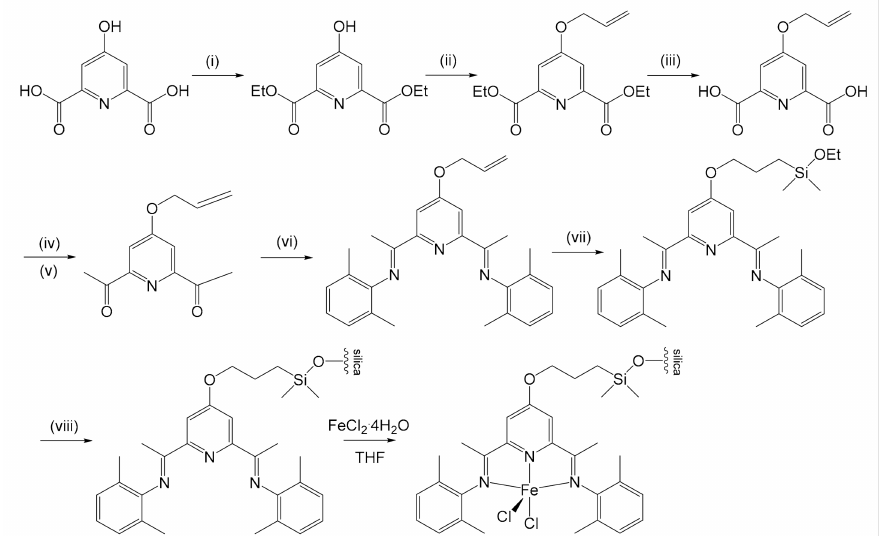
Figure 4. Kim’s immobilization strategy over silica for iron pre-catalyst [50]. Conditions: (i) EtOH, concentrated H 2 SO 4 , 90 ◦ C; (ii) K 2 CO 3 , allyl bromide, acetone, reflux; (iii) 5 eq L − 1 NaOH, THF, 50 ◦ C; (iv) SOCl 2 , DMF, 90 ◦ C; (v) CuI, MeLi, Et 2 O, THF, − 78 ◦ C; (vi) 2,6-dimethylaniline, EtOH, AcOH, reflux; (vii) (CH 3 ) 2 SiHCl, H 2 PtCl 6 · 6H 2 O (catalyst), CH 2 Cl 2 , EtOH:Et 3 N 1:1; reflux; (viii) silica gel, toluene, 120 ◦ C.